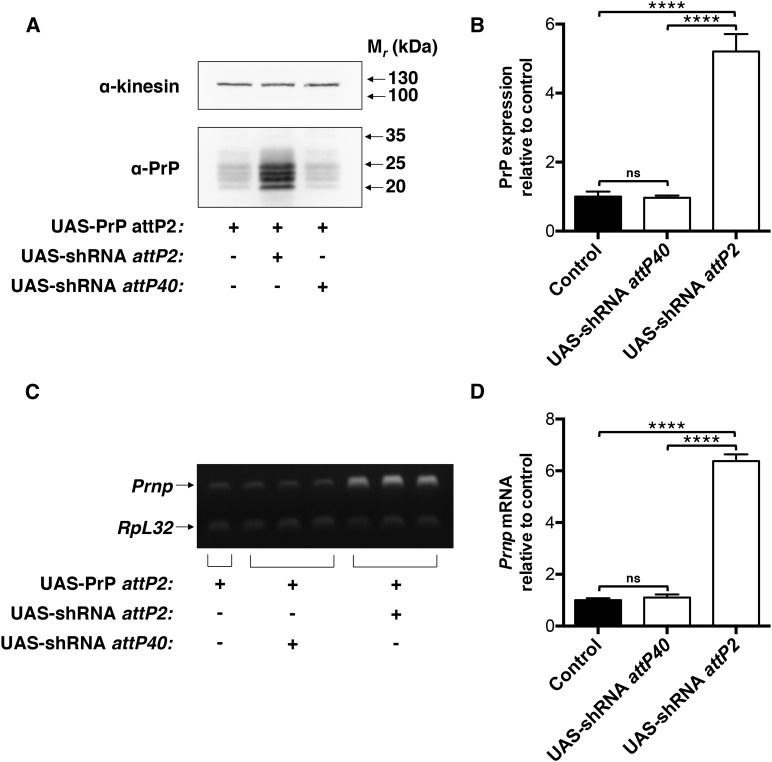
Control UAS-shRNA constructs from the Drosophila TRiP library enhance UAS-PrP transcriptional efficacy in trans. In flies expressing UAS-PrP from attP2 driven by Cha-GAL4, an shRNA hairpin against GFP was expressed at the paired attP2 or at the unpaired attP40 locus to assess the suitability of the TRiP library as an in vivo screening tool for transvection activity. (A) Western blot of fly head homogenates. Experiment was performed in triplicate with a representative blot shown. (B) Densitometry of Western blot signals in (A) and associated replicates. PrP signals were normalized to the kinesin loading control and then to the hemizygous attP2 UAS-PrP line lacking UAS-shRNA. (C) Semiquantitative RT-PCR performed on fly head mRNA. Prnp and RpL32 transcripts were coamplified in the same PCR reactions, and each lane represents a biological replicate. (D) Densitometry of RT-PCR signals in (C). For each sample, the ratio of Prnp to RpL32 mRNA levels was taken and then normalized to the average value for the attP2 UAS-PrP line lacking UAS-shRNA. Error bars in (B) and (D) represent standard deviations (n = 2 for UAS-PrP alone mRNA quantification, n = 3 for all other groups); ns denotes not significant and **** P < 0.0001. GFP, green fluorescent protein; mRNA, messenger RNA; PrP, prion protein; RT-PCR, reverse transcription polymerase chain reaction; shRNA, short hairpin RNA; TRiP, Transgenic RNA Interference Project.